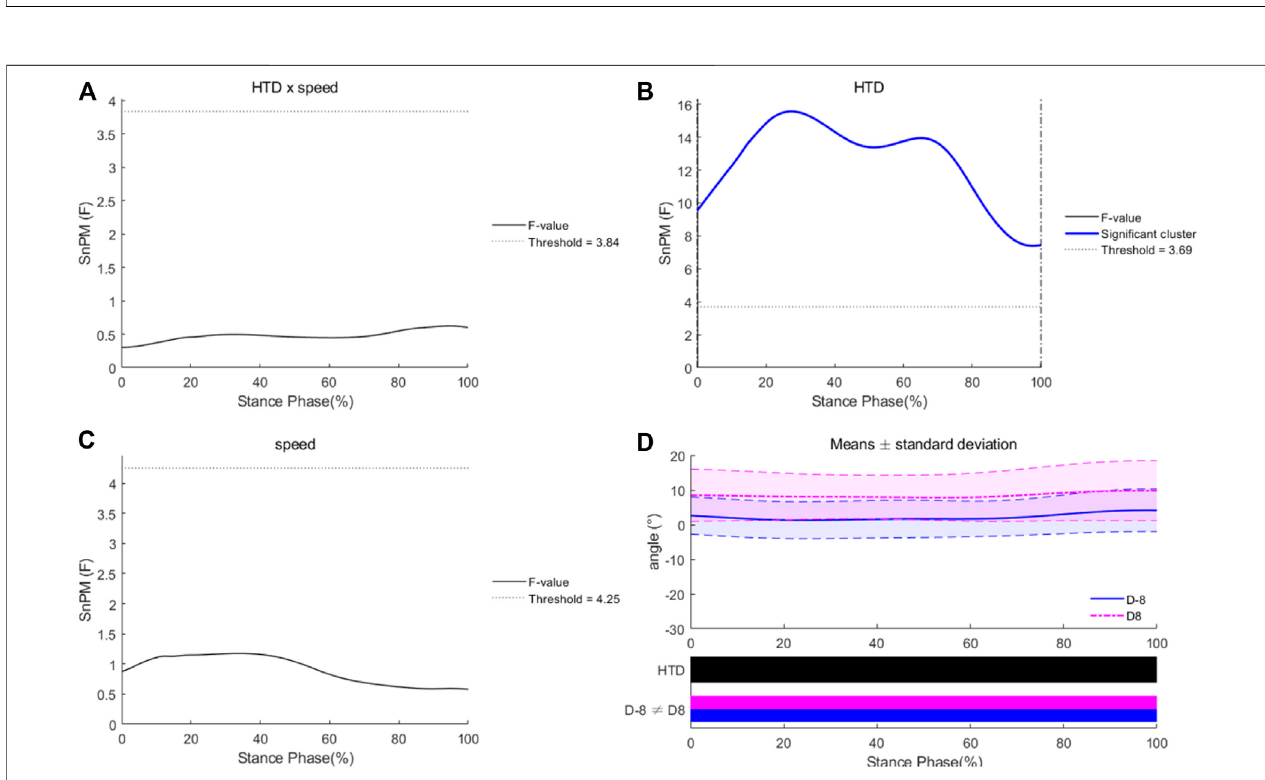
FIGURE4| DifferencesofMTPanglesinthehorizontalplaneunderdifferentHTDsandrunningspeeds.Interaction (A) ,maineffectsofHTD (B) andspeed (C) ,and post hoc test for HTD (D) .